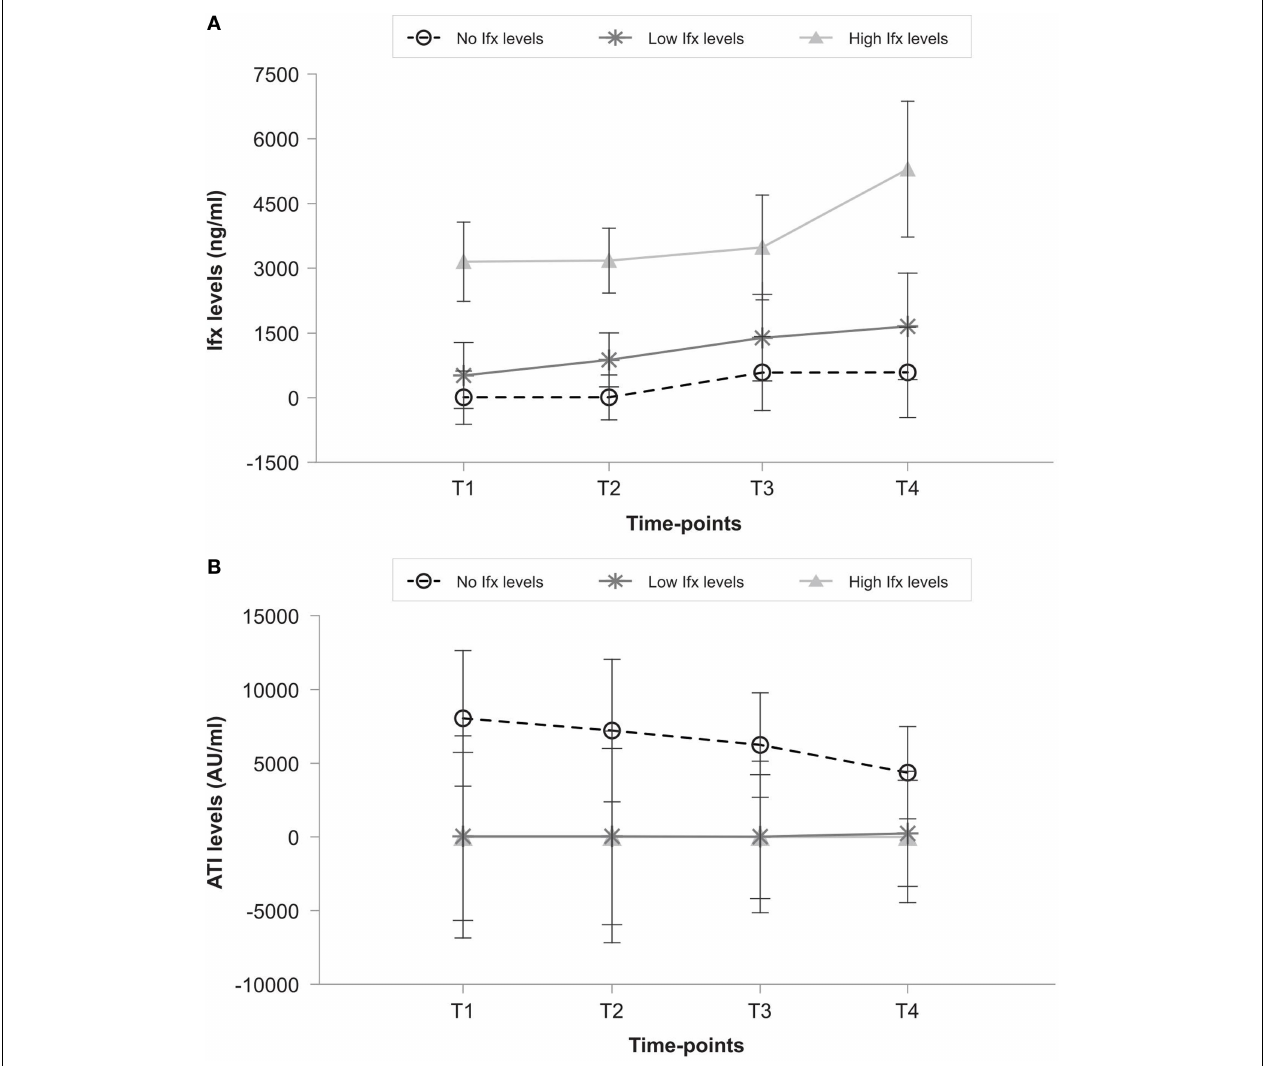
FIGURE 2 | (A) Ifx levels and (B) ATI levels in patients with no, low, and high Ifx serum concentrations at baseline. T1 (baseline), T2 (post-Ifx dose increment), T3 (at 6months), T4 (at 12months).